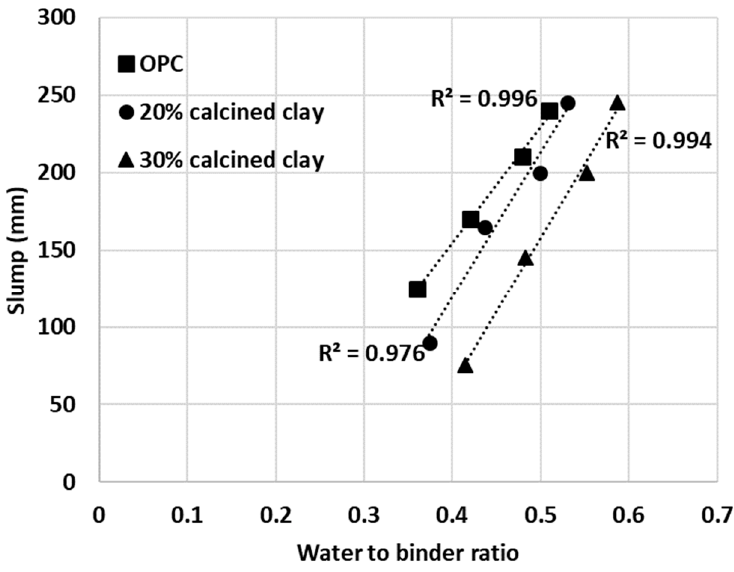
Likewise, the third data point for that line represents the w:b ratio required to achieve the same slump value for a 30% calcined clay mortar: